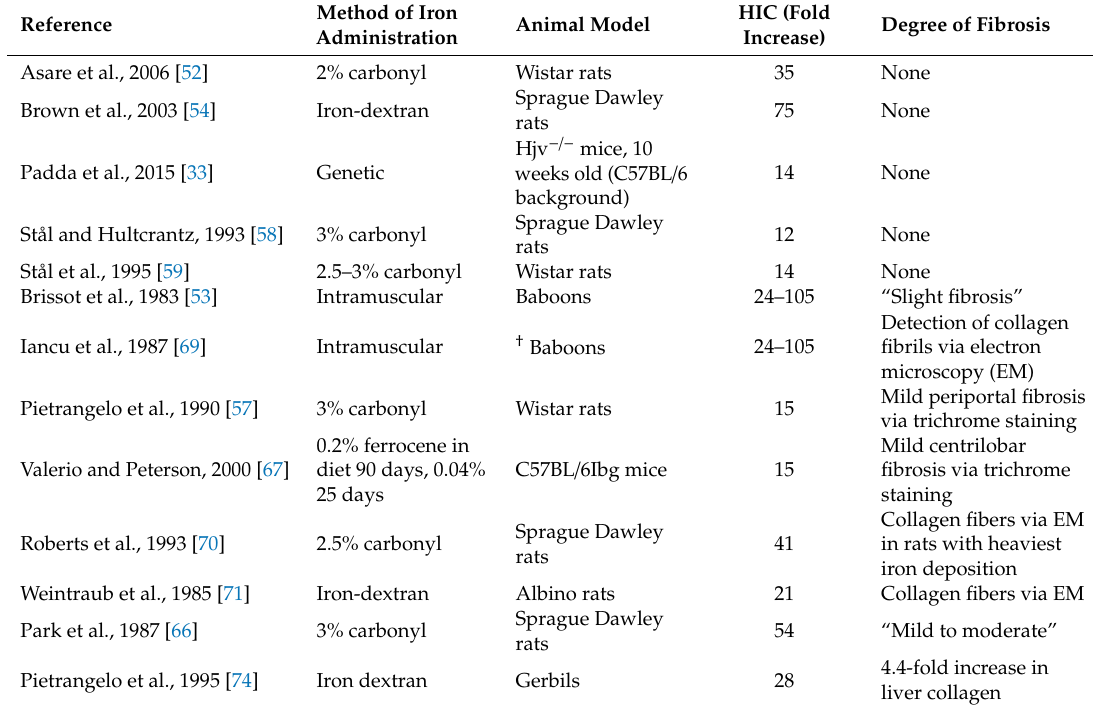
Table 1. Animal models of chronic iron overload and degrees of